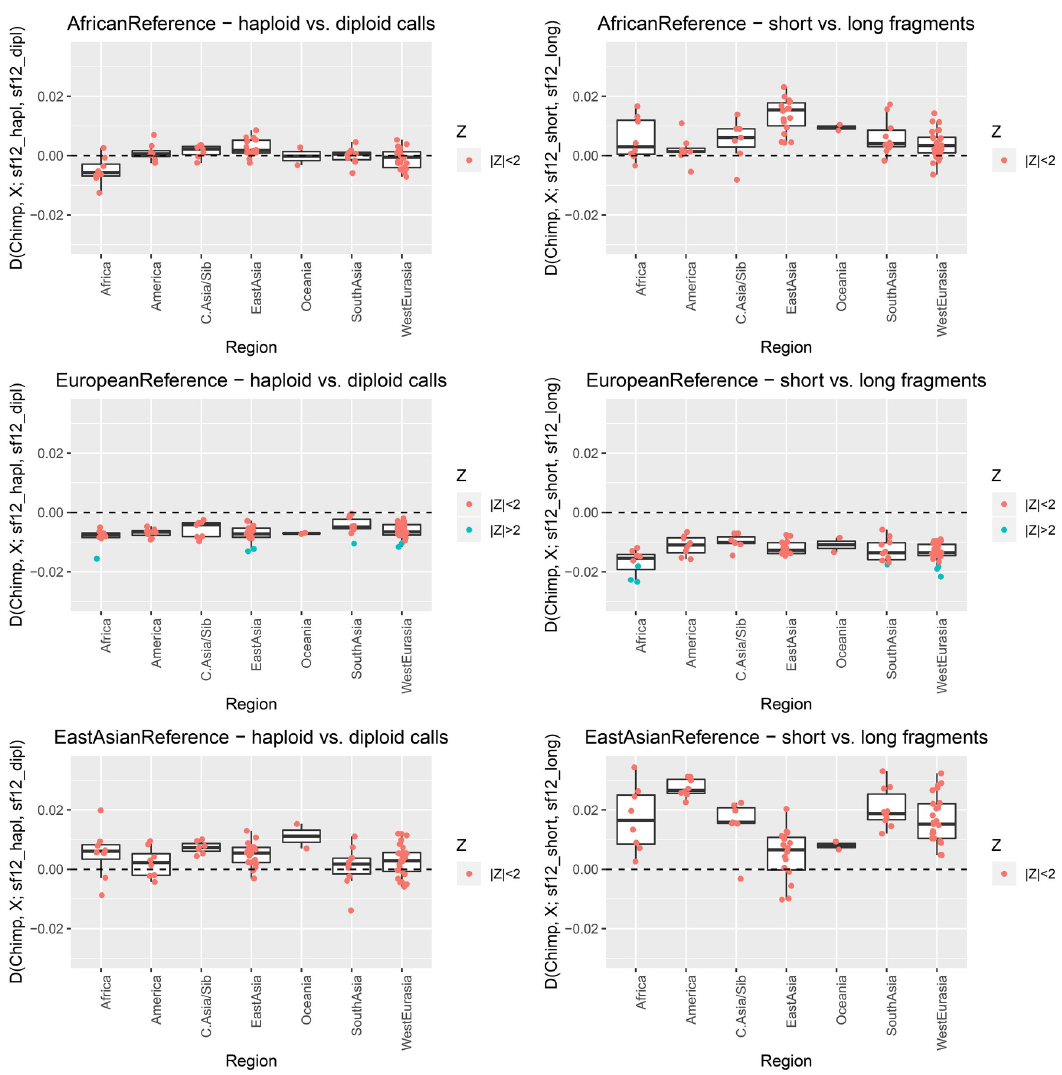
Fig 4. D statistics similar to Fig 3 for different parts of the reference genome depending on their geographic origin [44]. The x axis represents the geographic origin of population X .